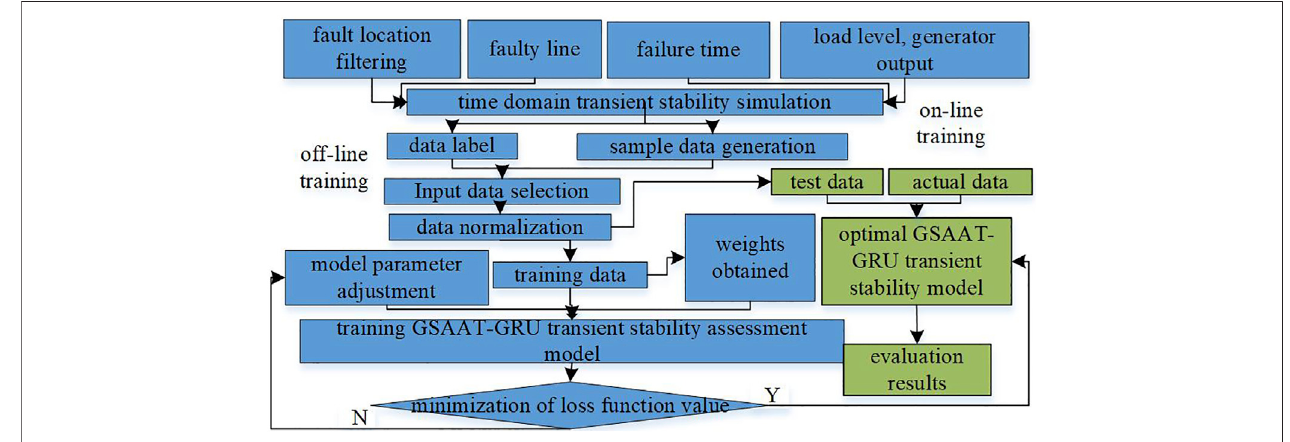
FIGURE 4 | General evaluation fl ow chart.